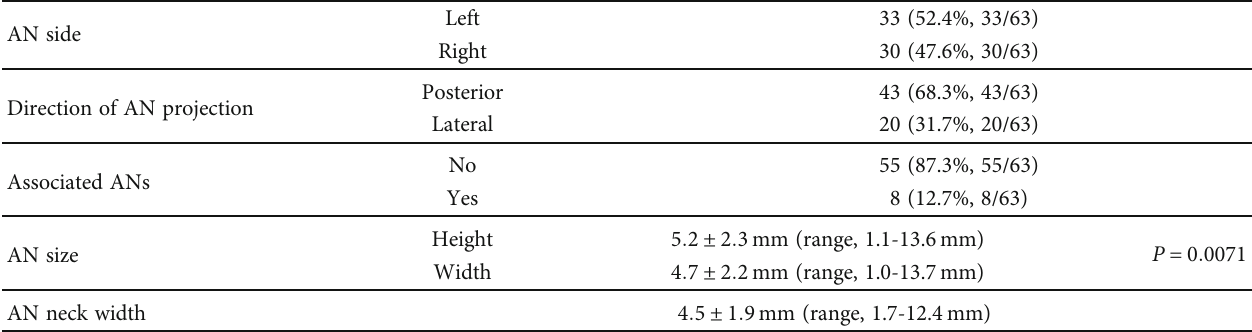
Figure 4: PcomA development as shown by CTA is as follows: (a) Grade I is de fi ned by the absence of the PcomA; the arrow indicates the aneurysm. (b) Grade II is de fi ned by the presence of a thin PcomA (asterisk); the arrow indicates the aneurysm. (c – d) Grade III is de fi ned by the presence of a thick fetal-type PcomA (asterisk); the arrow indicates the aneurysm. Abbreviations: CTA: computed tomography angiography; ICA: internal carotid artery; PCA: posterior cerebral artery; PcomA: posterior communicating artery. Table 1: Aneurysm